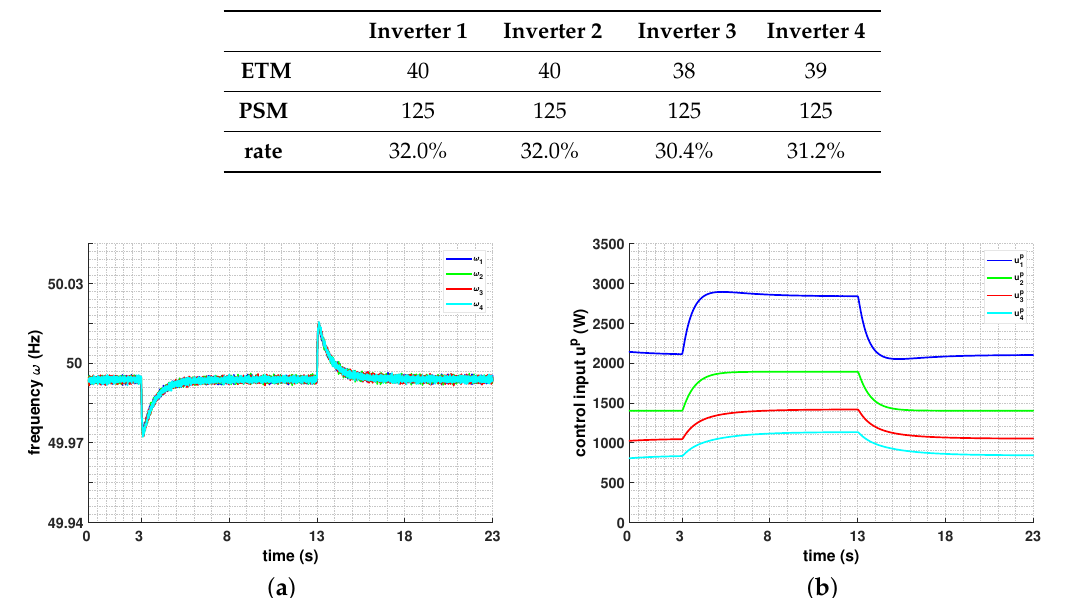
Table 1. Sampling number in Case A (event-triggered mechanism (ETM) vs. periodic sampling mechanism (PSM)).